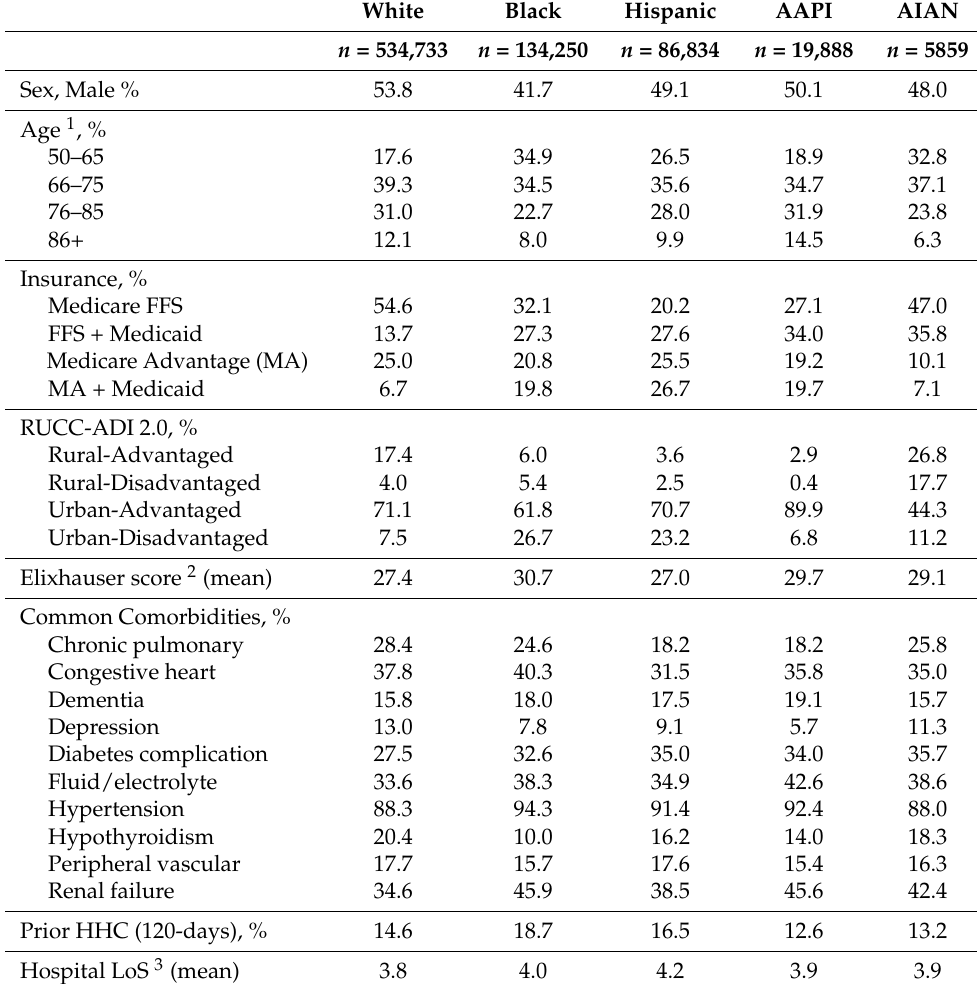
Table 2. Sample characteristics by race/ethnicity, column percentage unless otherwise